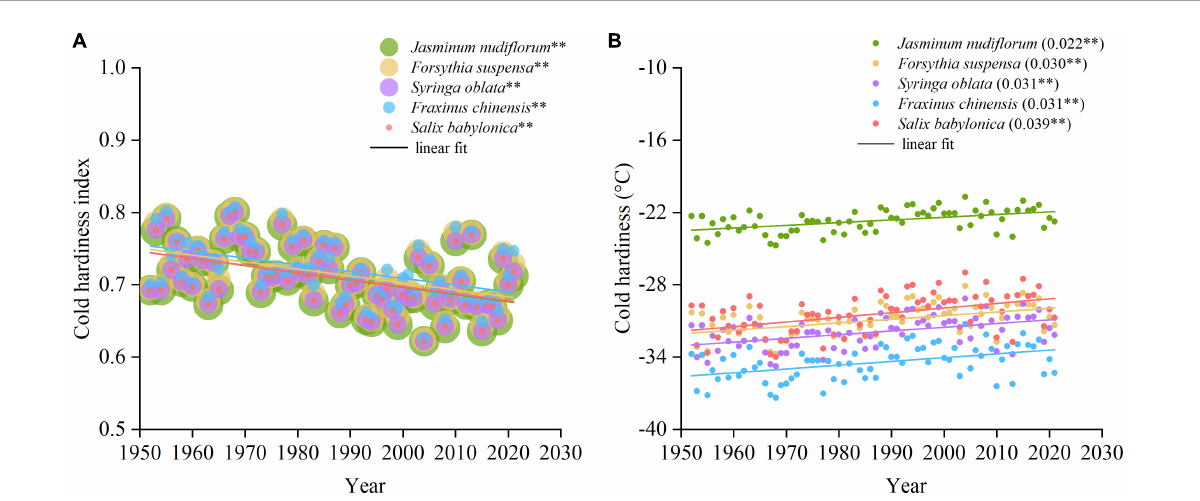
FIGURE7 Changes in maximum cold hardiness index (CHI) and cold hardiness for five species in the past 70 years (1952–2021). (A) Maximum CHI. (B) Maximum cold hardiness simulated by CHI. The slopes and significance levels of the linear function are shown in parentheses. ∗∗ p < 0.01.